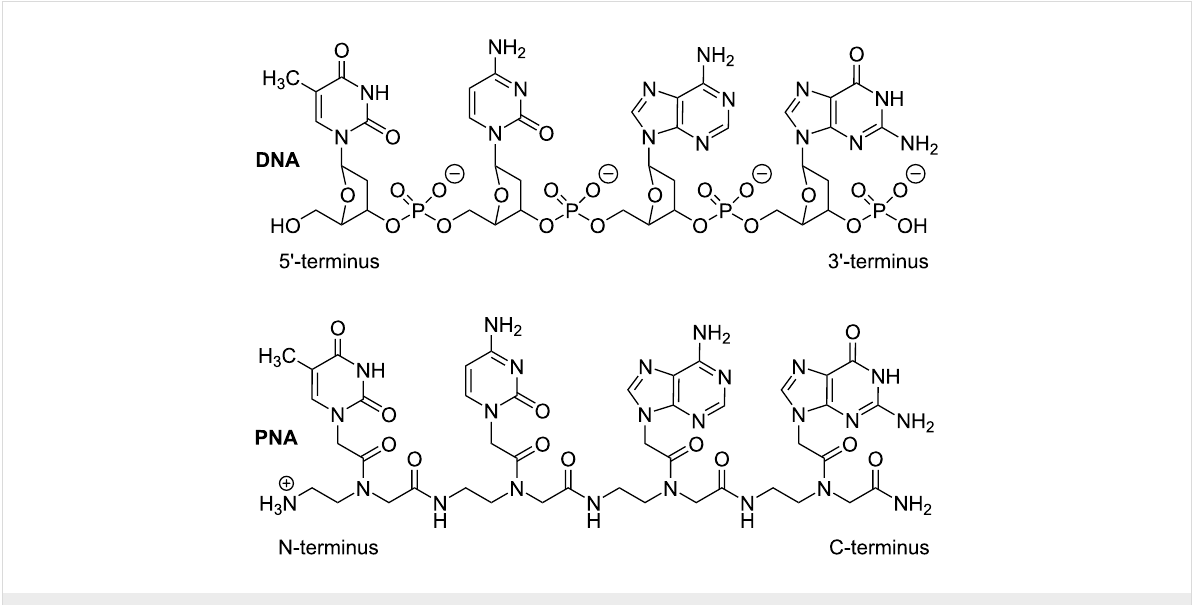
Figure 1: Structure of DNA and